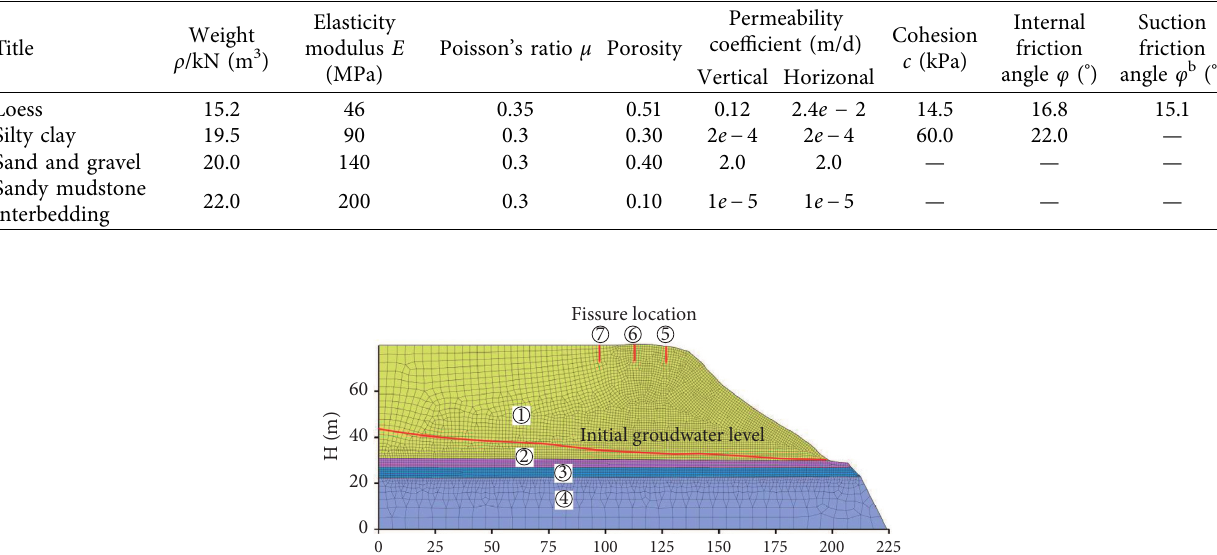
Table 2: Material parameters of the model [1, 2].